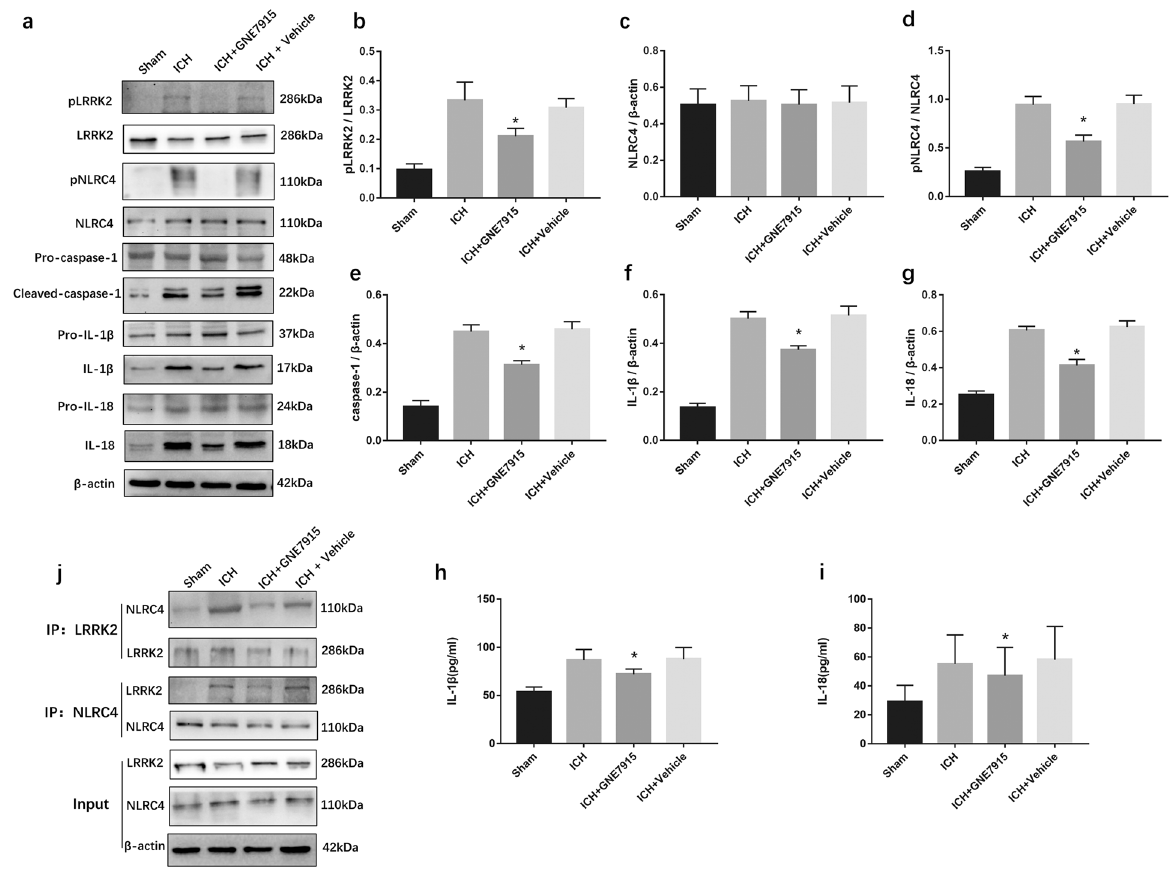
Fig. 6 LRRK2 inhibitor extenuated NLRC4 in fl ammasome activation after ICH. a – g Western blot assay to detect LRRK2, pLRRK2, NLRC4, pNLRC4, pro- IL-1 β , IL-1 β , Pro- caspase-1, caspase-1, Pro-IL-18, and IL-18 ( h and i) ELISA for IL-18 and IL-1 β ( j ) Co-Immunoprecipitation assay for NLRC4 and LRRK2, in peri-hematoma area in sham, ICH, ICH + GNE7915, and ICH + Vehicle groups at 72 h after ICH (six rats for each group). * P < 0.05, compared with ICH.